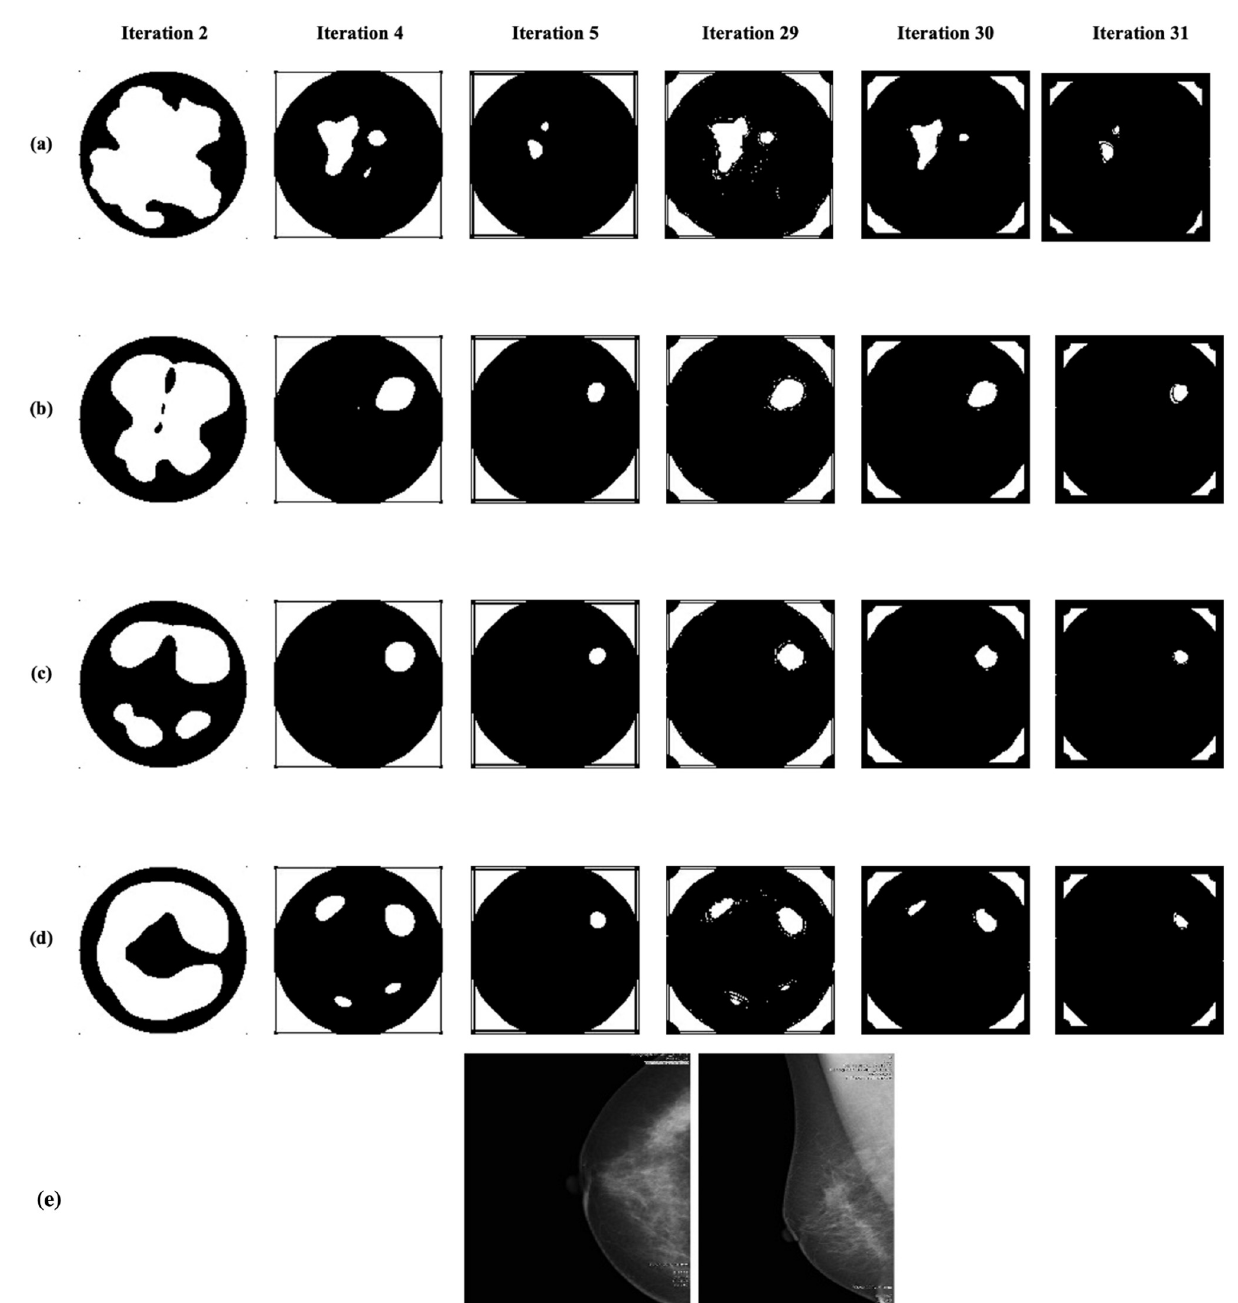
Fig 6. The results obtained over PCNN iterations for one of the NF+BF breast images with different conductivity: (a) Input image formed using σ 1 , (b) input image formed using σ 2 , (c) input image formed using σ 3 , and (d) input image formed using σ 4 . The radiologist study review “NF” for this scattered area of fibroglandular density breast has been obtained with the support of mammography images given in the bottom row. obtained using different conductivity levels have been introduced and used for breast lesions detection. The radiological reviews have also been compared here for WF breasts (from Table 2) to perceive if the identified lesion positions are or are not the same which gives a posi- tive impression on the results obtained from PCNN. All the locations of the lesions found matches with the radiologist’s location findings.